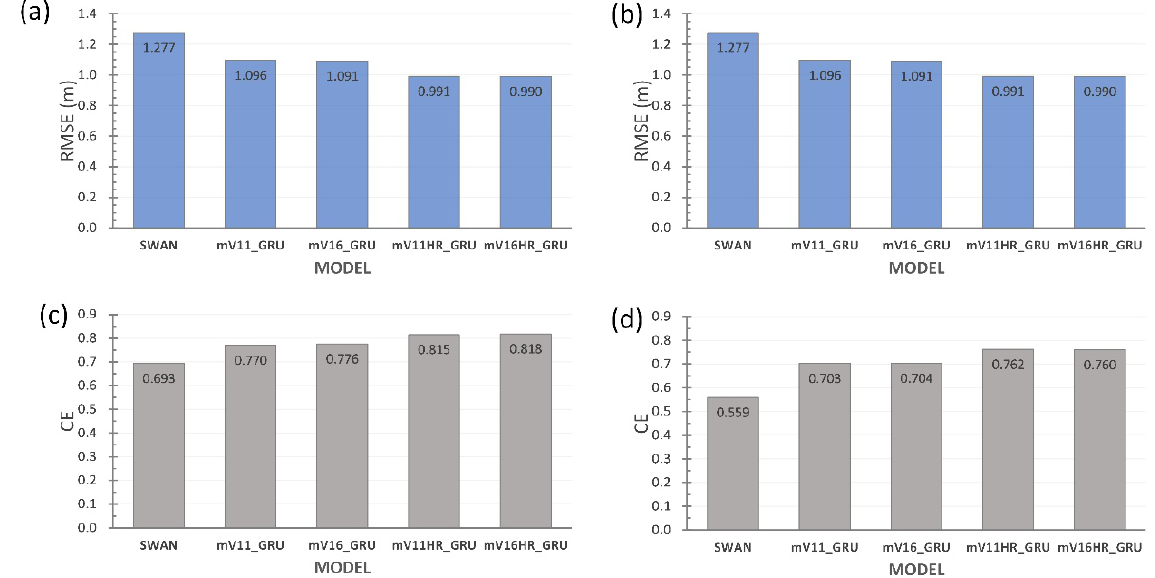
Figure 14. Comparison of the SWAN and AI-based models in regard to the metrics of the ( a ) RMSE for Longdong, ( b ) RMSE for Guishandao, ( c ) CE for Longdong, and ( d ) CE for Guishandao.